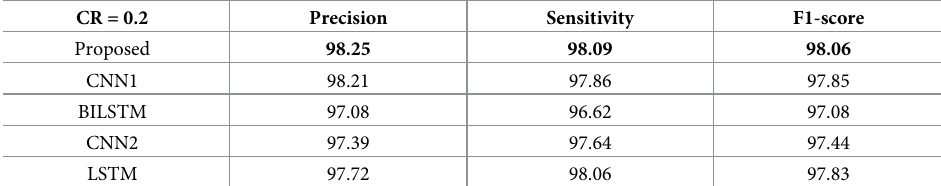
Table 8. Average precision, sensitivity and F1-score of each classification network at CR = 0.2. CR = 0.2